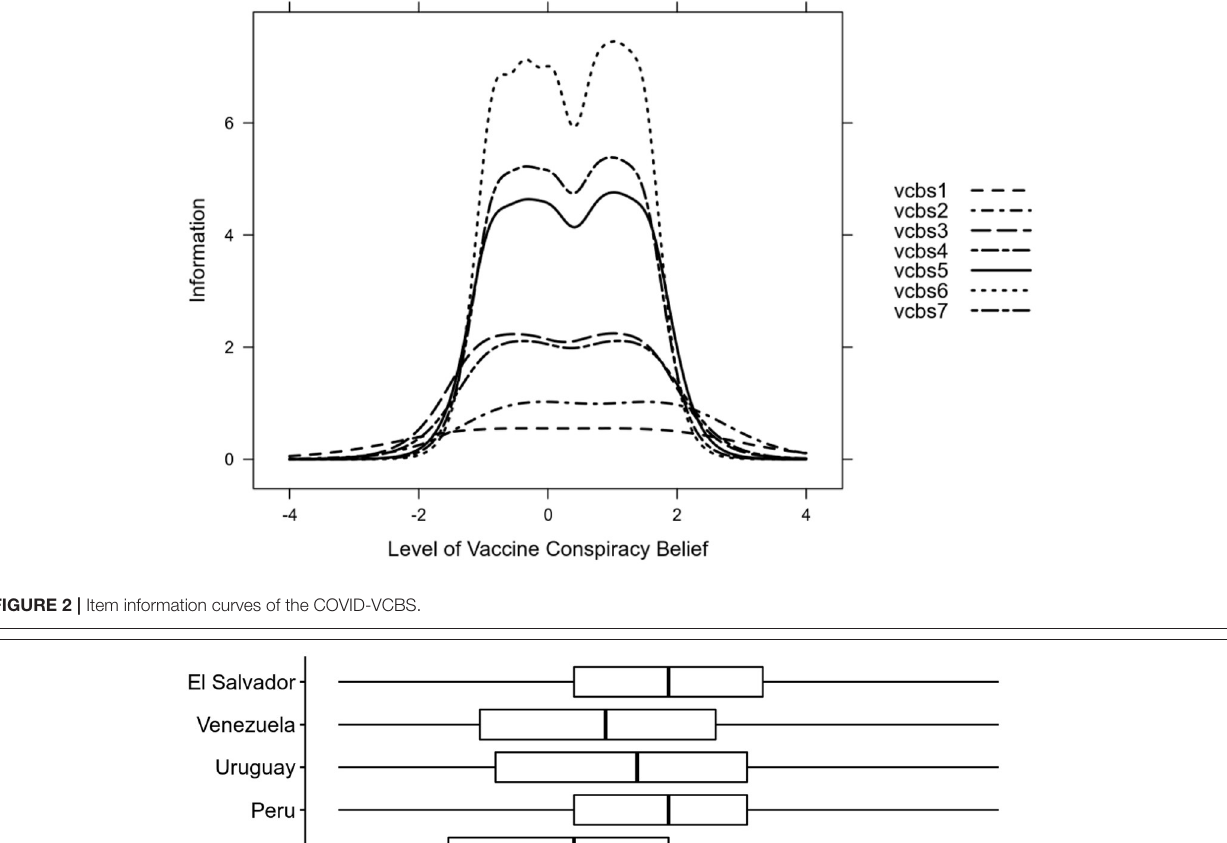
FIGURE 2 | Item information curves of the COVID-VCBS.